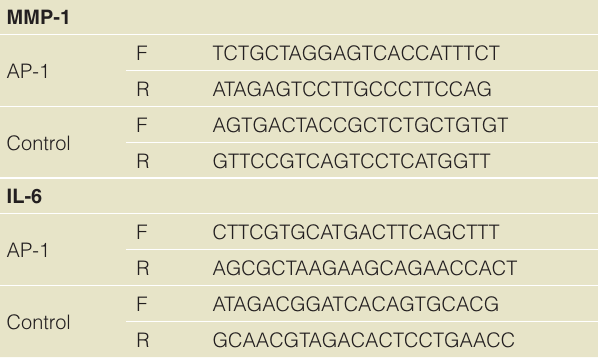
Table 5. Primer sequences used for chromatin immunoprecipitation experiments to detect binding at AP-1 or control sites in the MMP-1 and IL-6